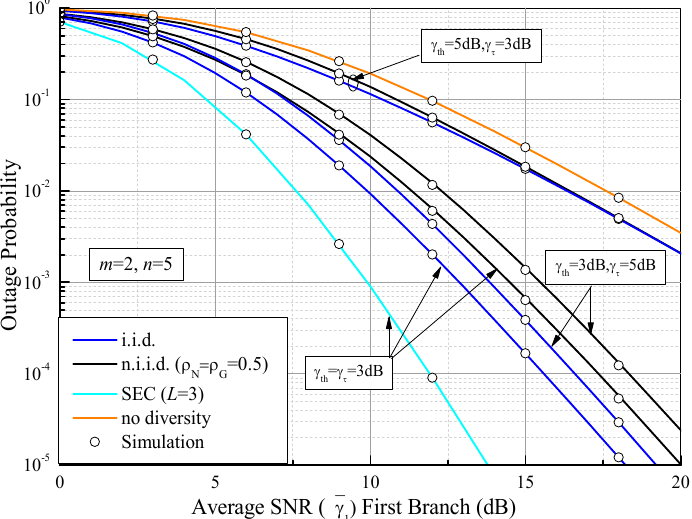
Figure 3. Outage probability values of dual-branch SSC and three-branch SEC systems as functions of the average SNR ( γ 1 ) first branch over Fisher–Snedecor F fading channels, with different values of γ th and γ τ and with m = 2 and n =